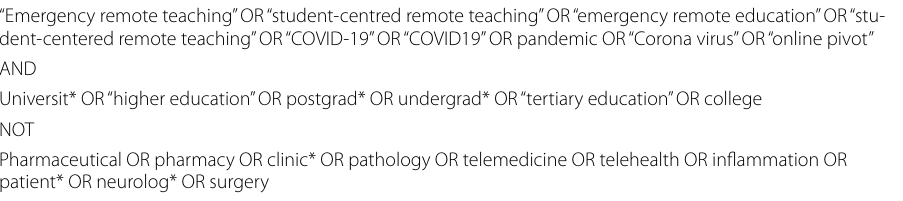
Table 1 Search string, English language studies